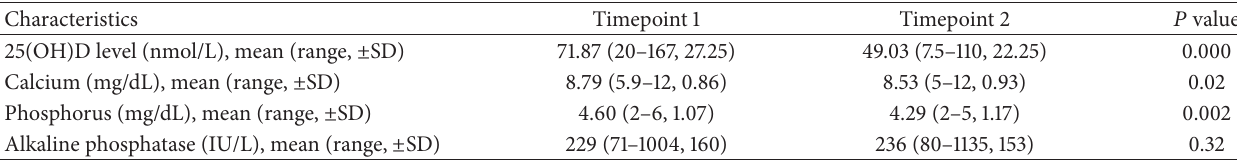
Table 3: Levels of 25(OH)D, calcium, phosphate, and alkaline phosphatase in study population at timepoint 1 and timepoint 2. Characteristics